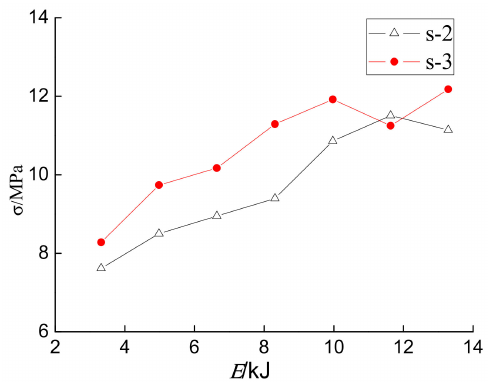
Figure 10. The internal forces detected by sensors S-2 and S-3 vs. the impact energy.